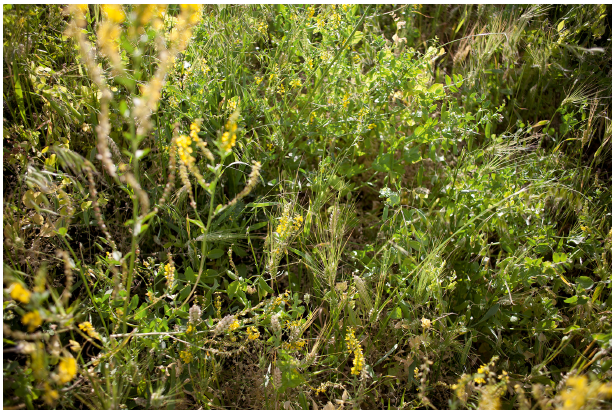
Fig. 2. Closeup image of the lashak-makh field in Fig. 1. Photograph by Frederik van